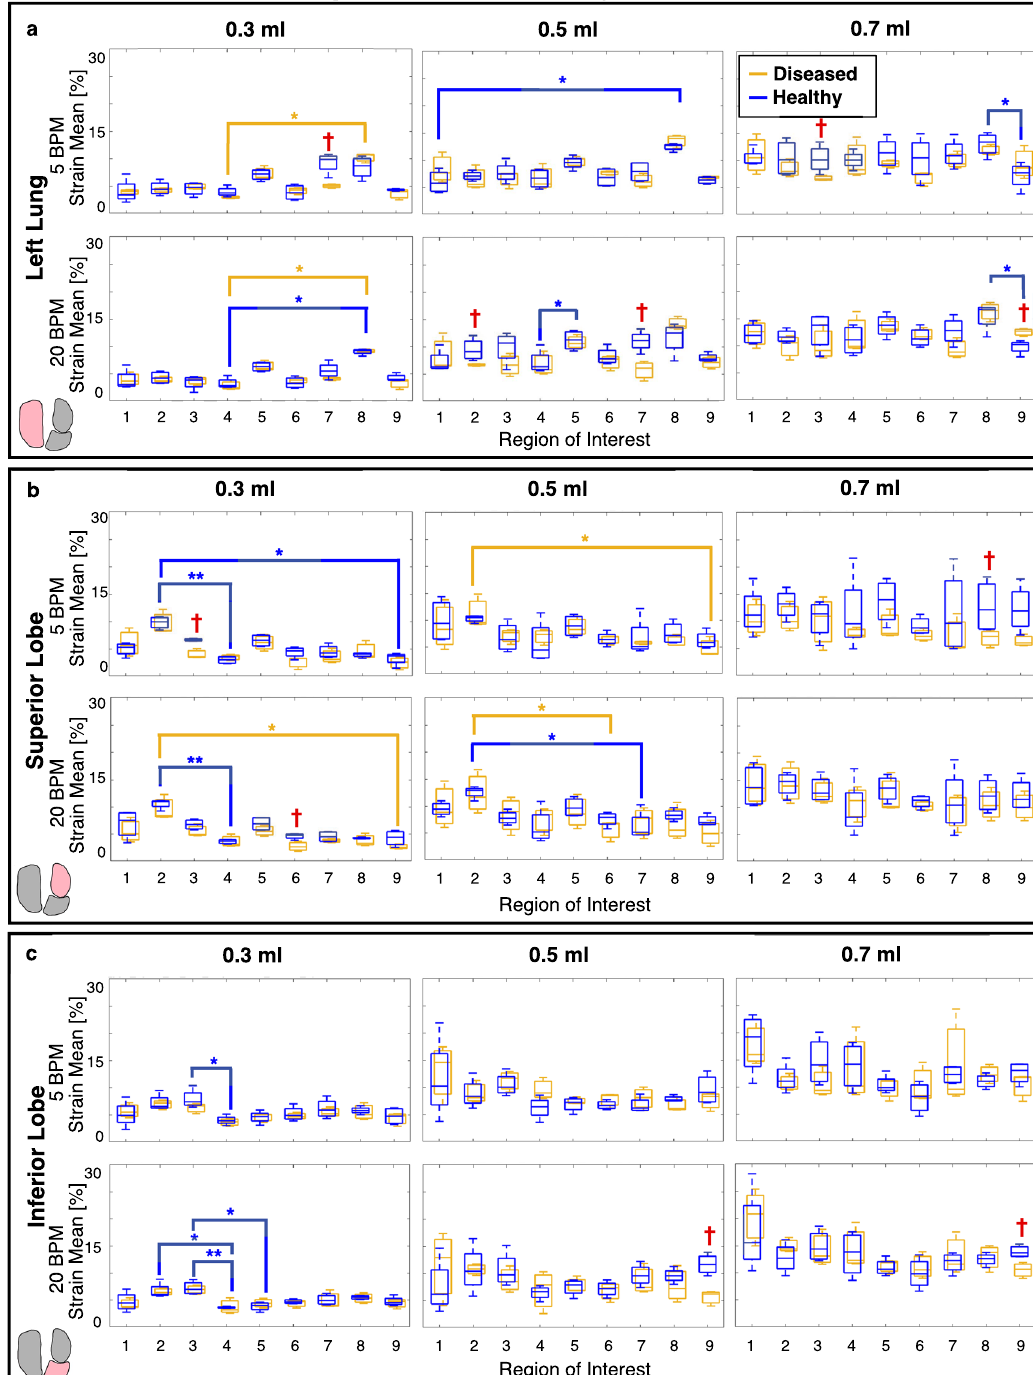
Figure 5. Diseased (gold) and healthy (blue) specimens’ peak inflation major strain mean values within each ROI for the ( a ) left lung, ( b ) superior lobe and ( c ) inferior lung surfaces, depicted via box and whisker plots. Applied volumes of 0.3, 0.5, and 0.7 ml at rates of 5 and 20 BPM are shown. Significant differences between diseased versus healthy ROI’s strain means are indicated with red daggers. Additionally, significant differences between each of the regions within diseased and healthy lungs’ groups are denoted by gold and blue asterisks,